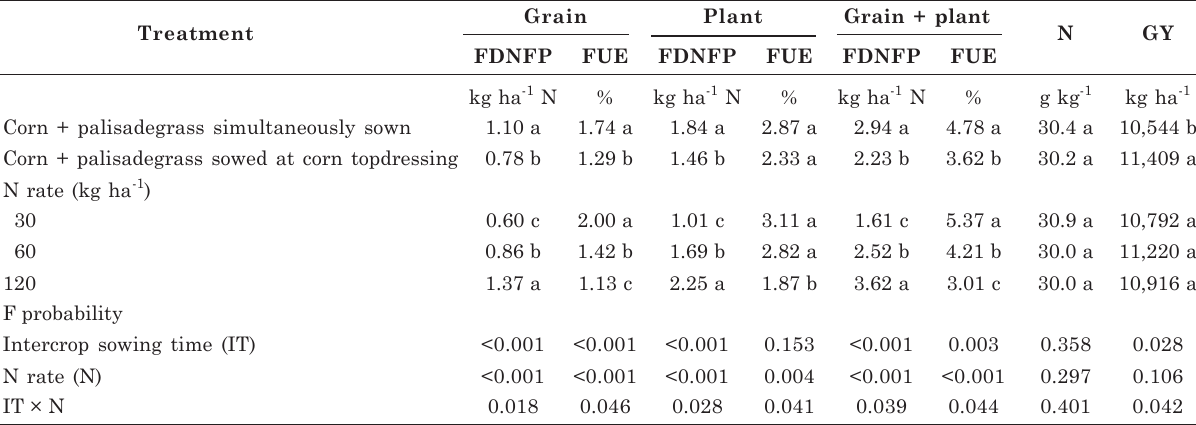
Table 3. Residual effect of N fertilization ( 15 NH 4 NO 3 ) applied in palisadegrass detected in corn by the evaluation of fertilizer-derived N content in grain, plant, and total (grain + plant) (FDNFP), N fertilizer use efficiency (FUE), N corn leaf concentration (N), and grain yield (GY) of corn sown into straw of palisade grass sown in two intercrops at different